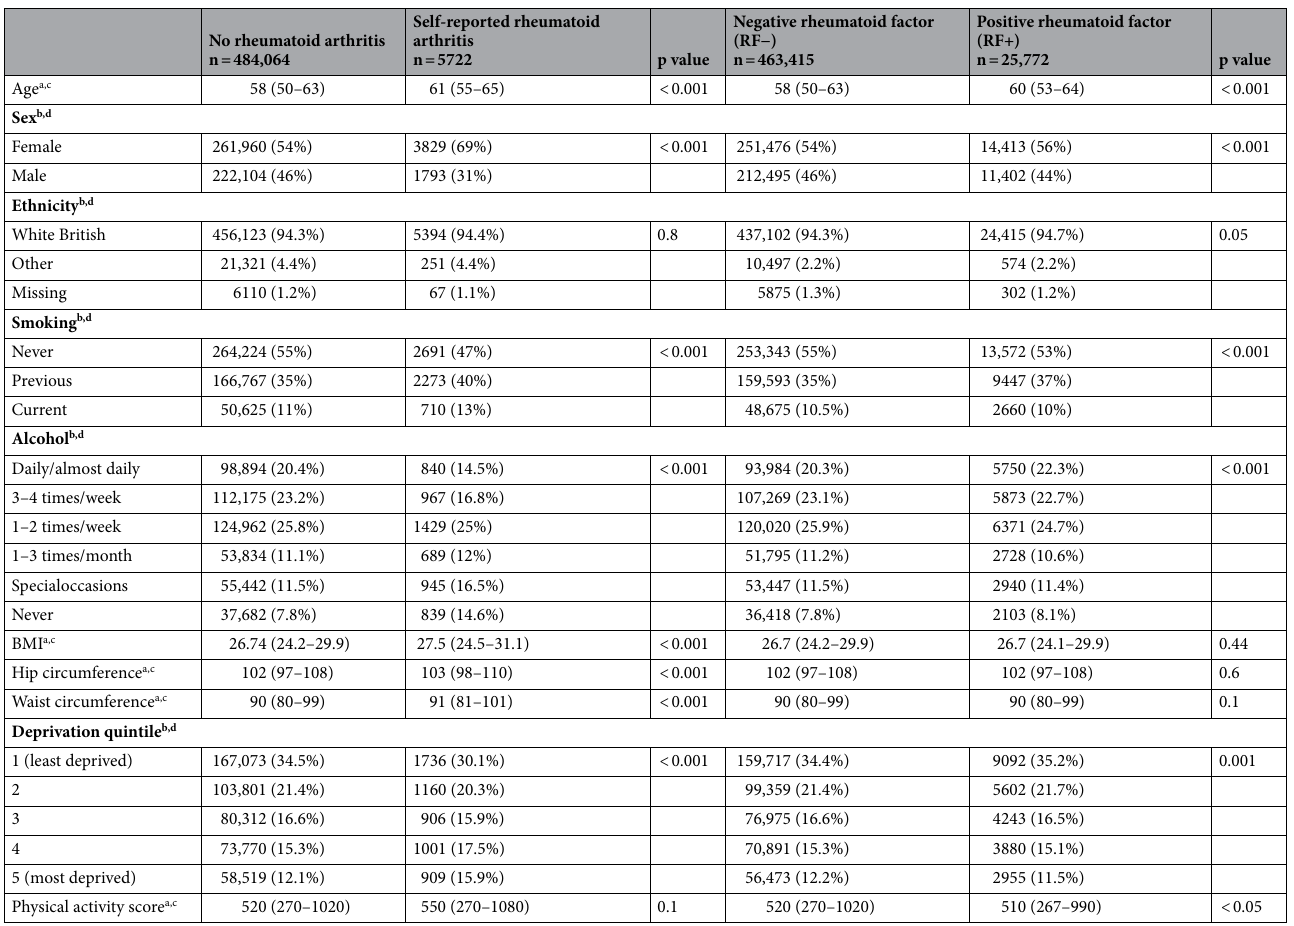
Table 1. Characteristics of participants with/without rheumatoid arthritis and by rheumatoid factor seropositivity. a Kruskal-Wallis test. b Pearson χ 2 test. c Median (IQR). d N (%).